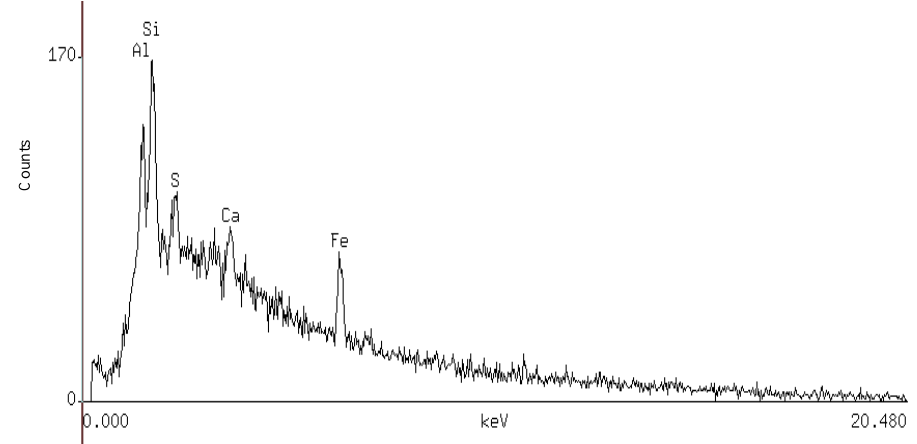
Figure 3. EDS of material graphite.